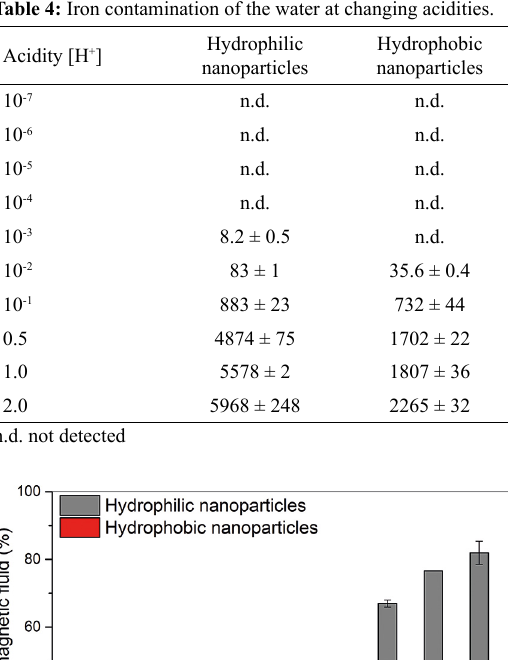
Table 4: Iron contamination of the water at changing acidities.